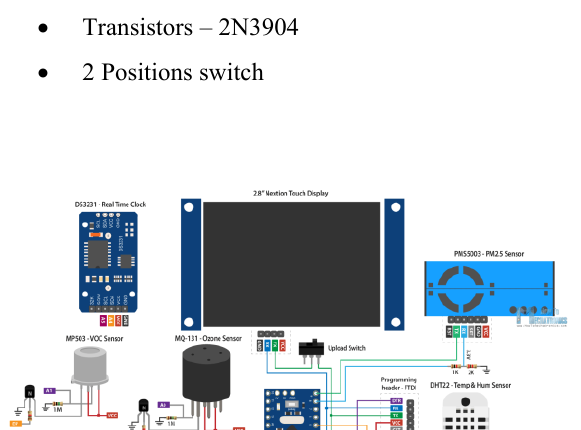
Figure 8. GCM connection to Arduino